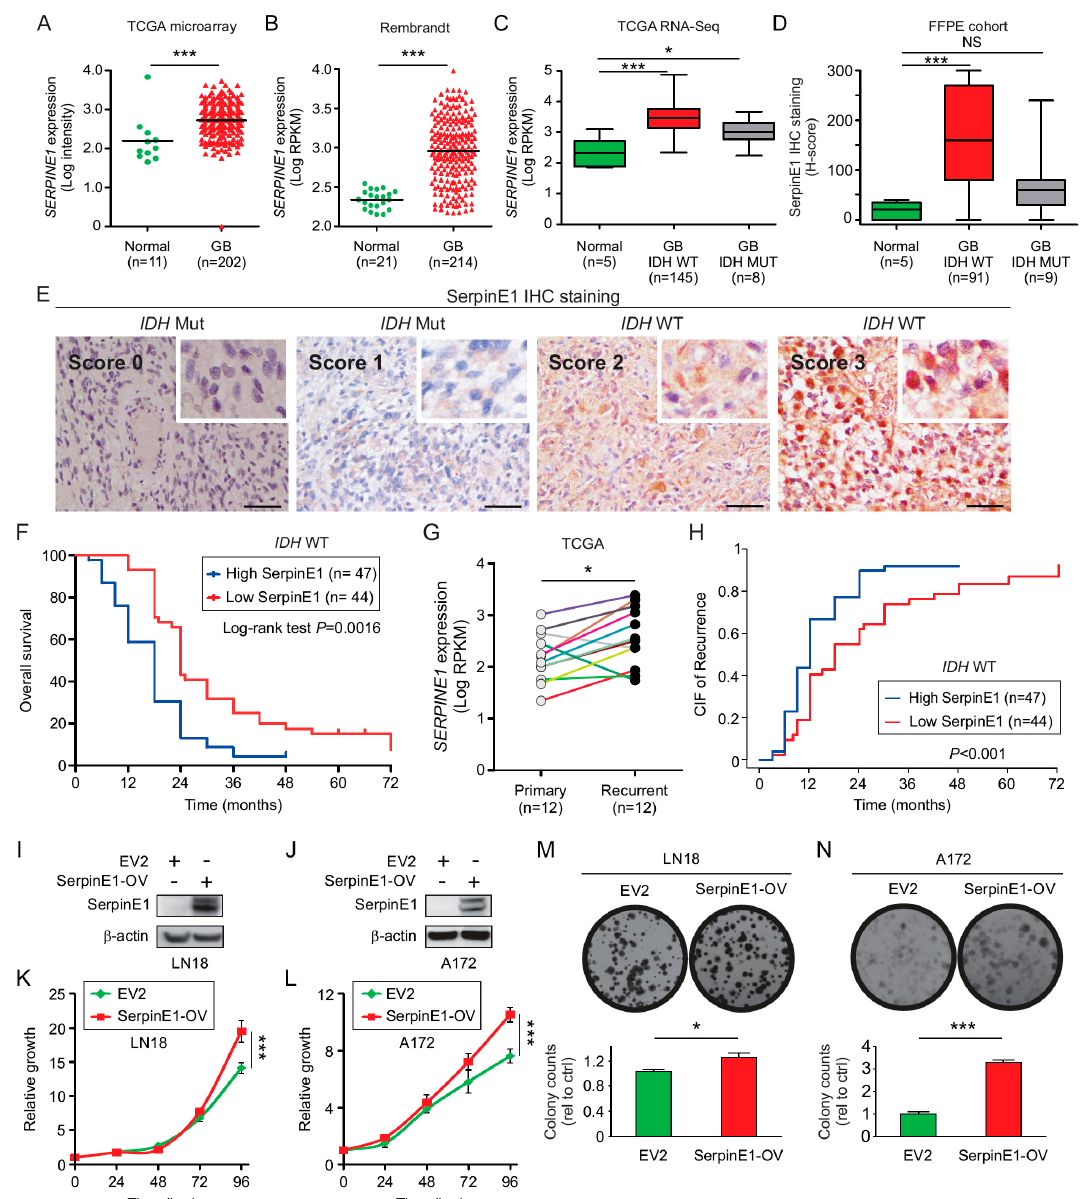
Figure 3. Proliferation and invasion analysis in GB cells with SerpinE1-OV. ( A ) TCGA database analysis of SERPINE1 in GB tissue ( n = 202) compared to normal brain tissue ( n = 11) ( t -test, *** p < 0.001). ( B ) Rembrandt database analysis of SERPINE1 expression in GB tissue ( n = 214) compared to normal brain tissue ( n = 21) ( t -test, *** p < 0.001). ( C ) Boxplot of SERPINE1 expression in IDH WT ( n = 145) or mutated ( n = 8) GB patients using the RNA-sequencing TCGA dataset and compared to normal brain tissue ( n = 5) (Kruskal–Wallis test, Dunn’s post hoc test * p < 0.05, *** p < 0.001). ( D ) Boxplot of SerpinE1 expression in FFPE samples from normal brain tissue ( n = 5) and GB tumors with IDH WT ( n = 91) or mutated ( n = 9) as determined by H-scores (Kruskal–Wallis test, Dunn’s post hoc test *** p < 0.001, NS = non-significant). ( E ) Representative IHC images for SerpinE1 staining in FFPE samples showing the scores (0, 1, 2, or 3). Scale bar = 50 µ m. ( F ) Kaplan–Meier curves to compare the percentage of survival in GB patients with a low ( n = 44) versus high ( n = 47) SerpinE1 expression (log-rank test, p = 0.0016). ( G ) SERPINE1 expression in primary GB tumors ( n = 12) paired with recurrent tumors ( n = 12, t -test, * p < 0.05). ( H ) CIF of recurrent GB patients with low ( n = 44) versus high ( n = 47) SerpinE1 expression ( p < 0.001). ( I,J ) Western blot analysis of SerpinE1 in LN18 ( I ) and A172 ( J ) cell lines expressing EV2 or SerpinE1-OV. ( K,L ) Proliferation assays in LN18 ( K ) and A172 ( L ) cell lines expressing EV2 or SerpinE1-OV (two-way ANOVA, Bonferroni